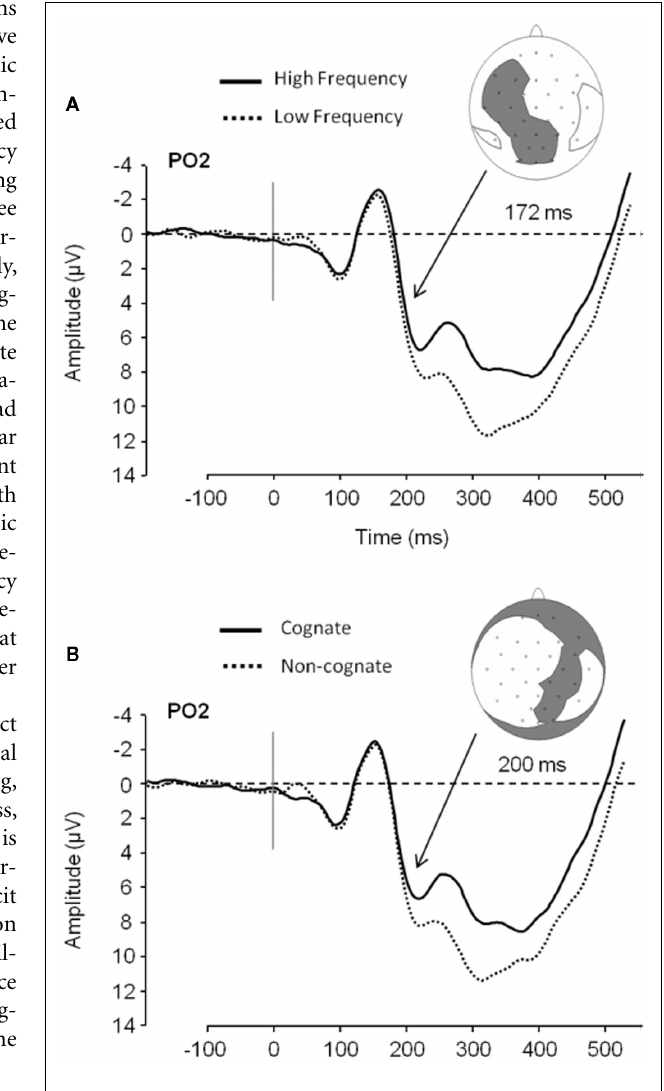
conceptual level due to the continuous cross-talk between the two representational systems (see Strijkers et al., 2010). To counter these potential concerns, Strijkers et al. (2010) compared the ERPs between their two experiments. The only difference between them was language dominance, namely bilinguals producing speech in L1 for Experiment 1 and in L2 for Experiment 2. The between- experiment comparison resulted in the same P2 modulation, with L2 naming eliciting more positive amplitudes compared to